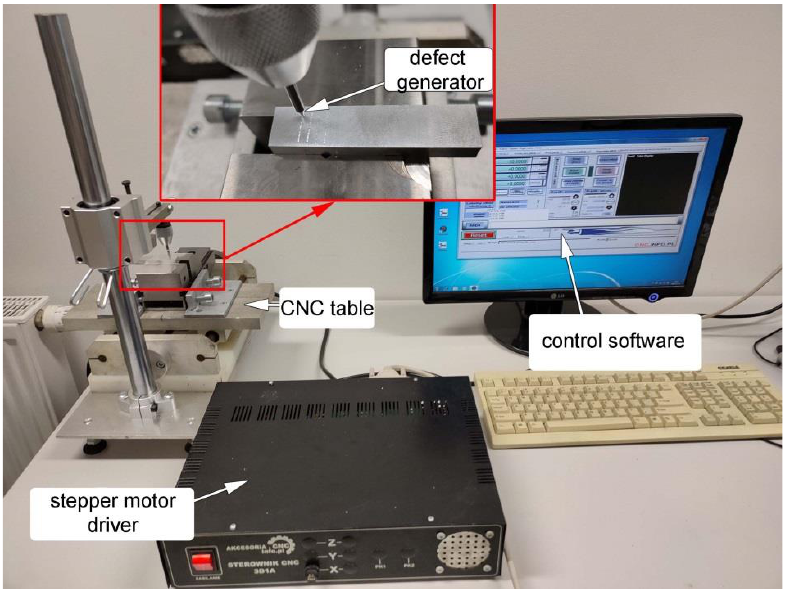
Figure 4. Test stand for generating surface defects.